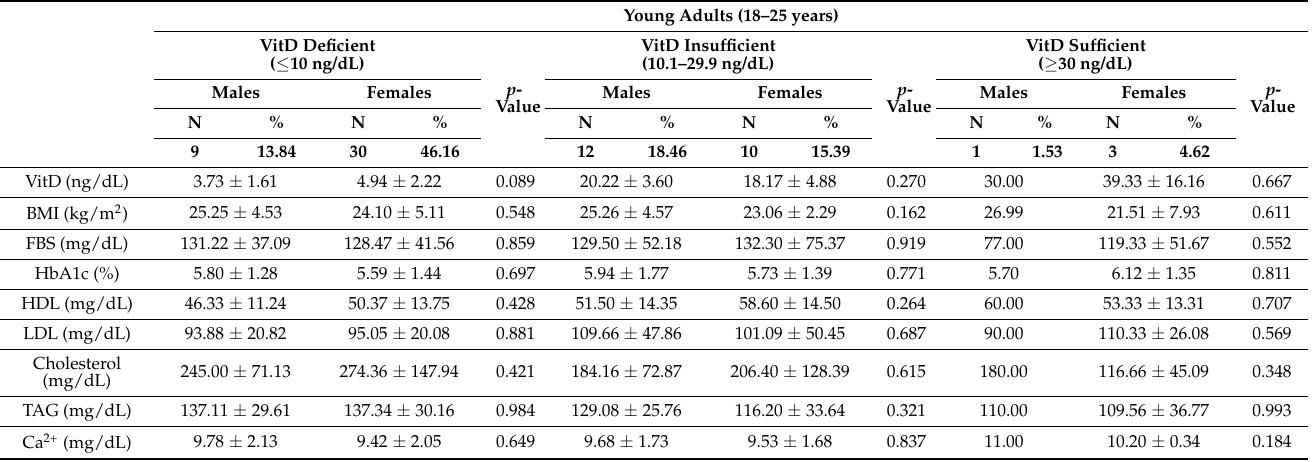
Table 2. VitD status and other health indicators in Libyan young adults (18–25 years) according to the VitD cut-off groups and